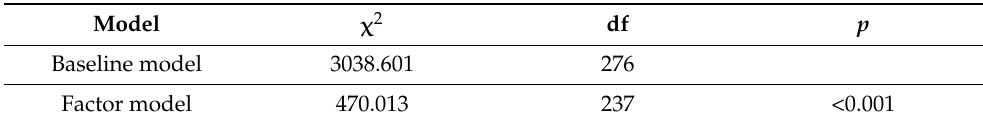
Table 2. Chi-squared distribution.